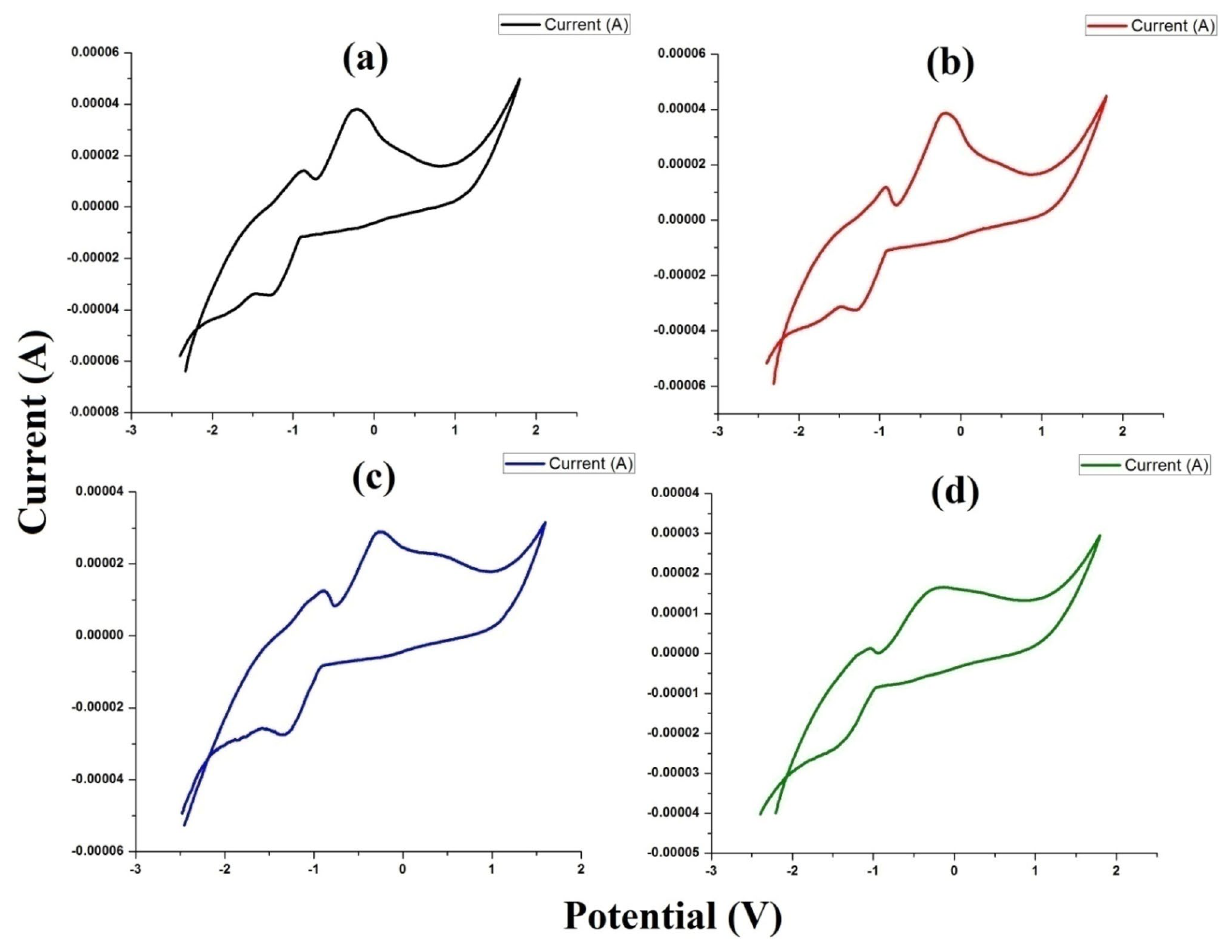
Fig. 8 CV analysis of Cd